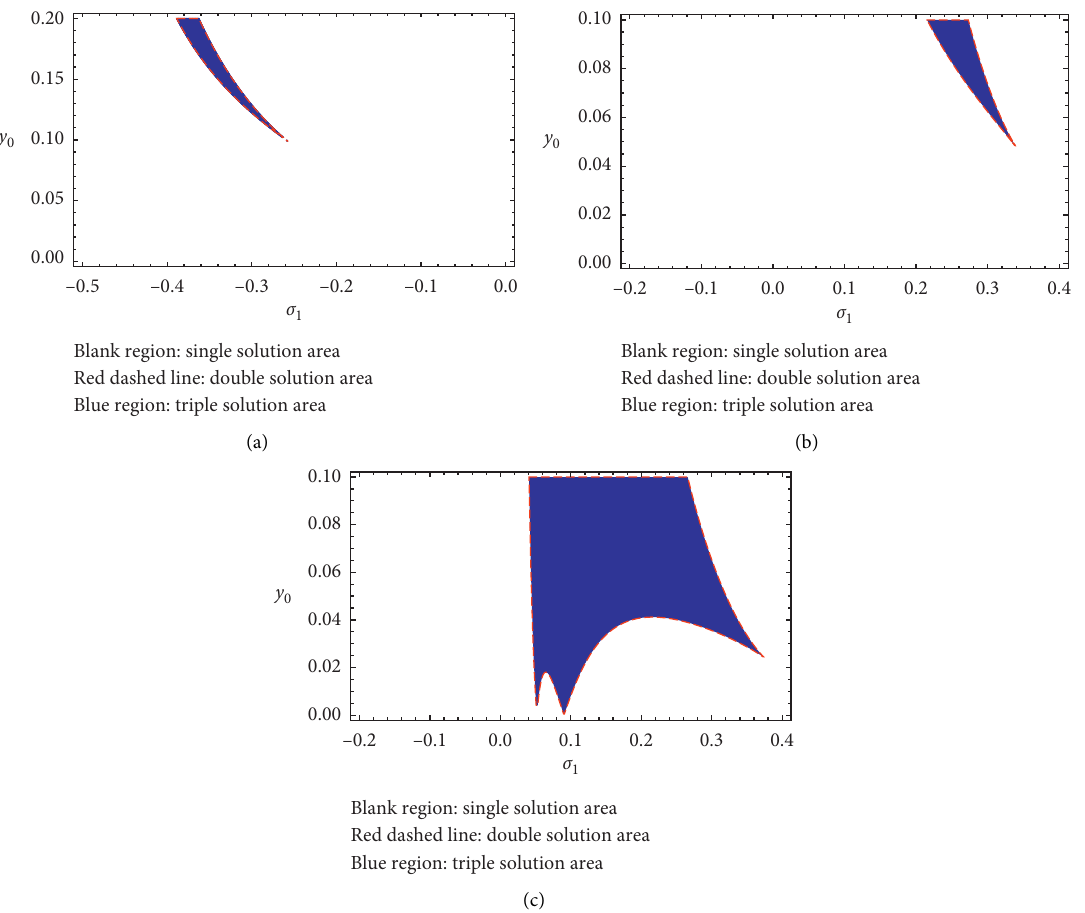
− σ plane: (a) the uncontrolled system; (b) the controlled system without time delay; (c) the 0 1 + τ � 0 . 03. 1 2